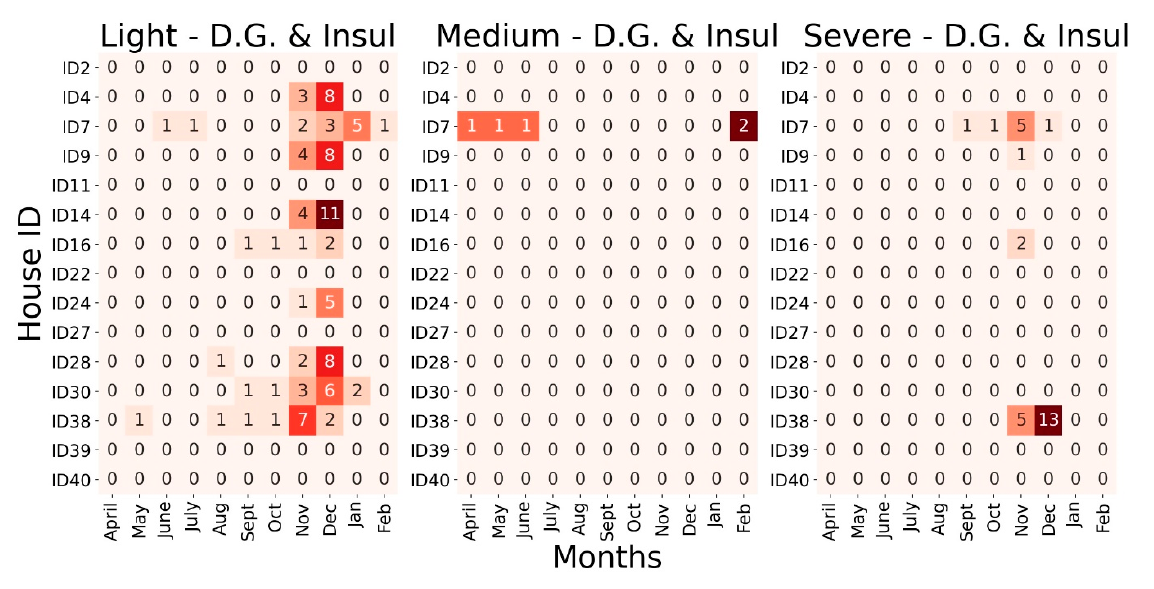
Figure A9. Results of the underheating criteria 2 applied to the models with insulation and double glazing. The X axis shows the months, and Y axis shows the house ID. The intersection of both shows the number of underheated light (left), medium (middle), and severe (right) days in that month.